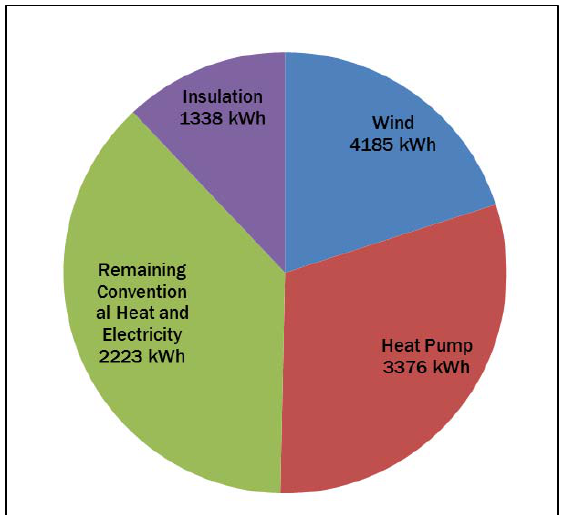
Figure 3. Farmhouse Wind Turbine Energy